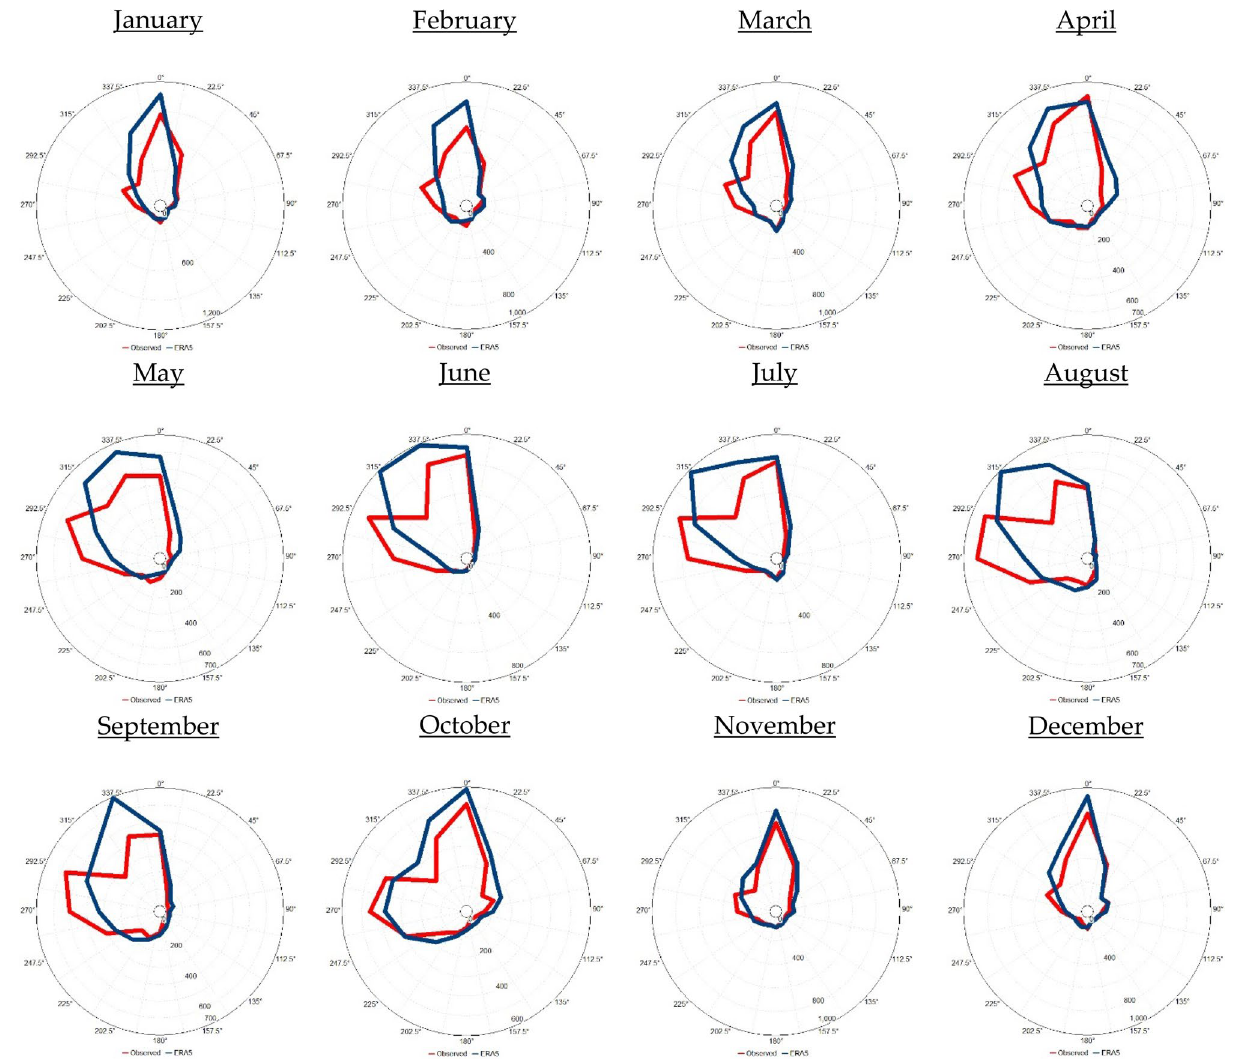
Figure 7. Observed (ERA5) monthly wind rose diagram based on the hourly observed (ERA5) data from 2016 to 2020 in Jeddah. The blue colour indicates the observations, while the red colour indicates the ERA5 data.